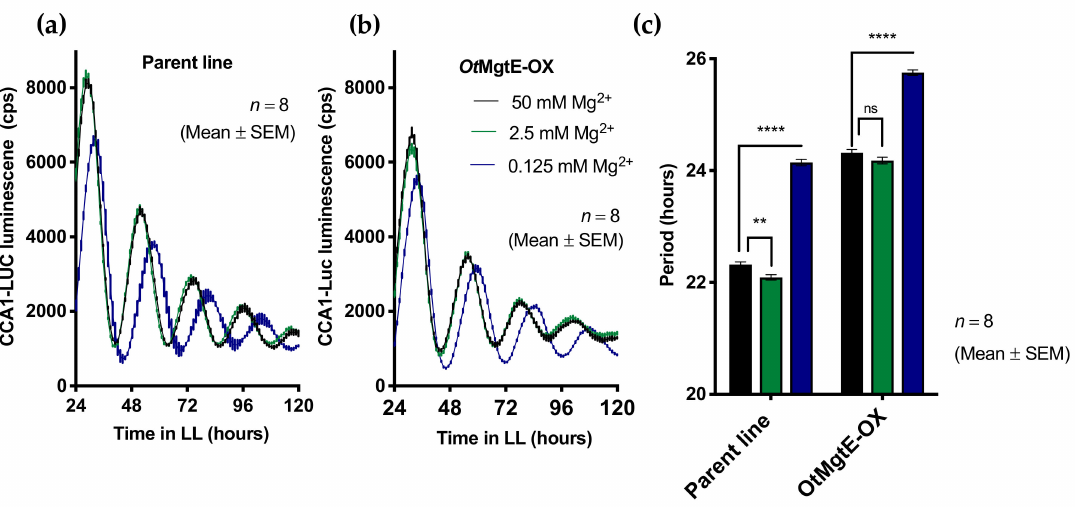
Figure 4. Overexpression of OtMgtE does not rescue the effect of low Mg 2+ on the circadian period. Luminescent traces of ( a ) the parent line and ( b ) Ot MgtE-OX at different concentrations of extracellular Mg 2+ . The graph shows a line through discrete time points, at a ~1-h sampling rate (mean ± SEM). ( c ) Free-running period calculated from bioluminescent traces in ( a , b ). ns: p > 0.05 **: p < 0.01 ****: p < 0.0001; student’s t